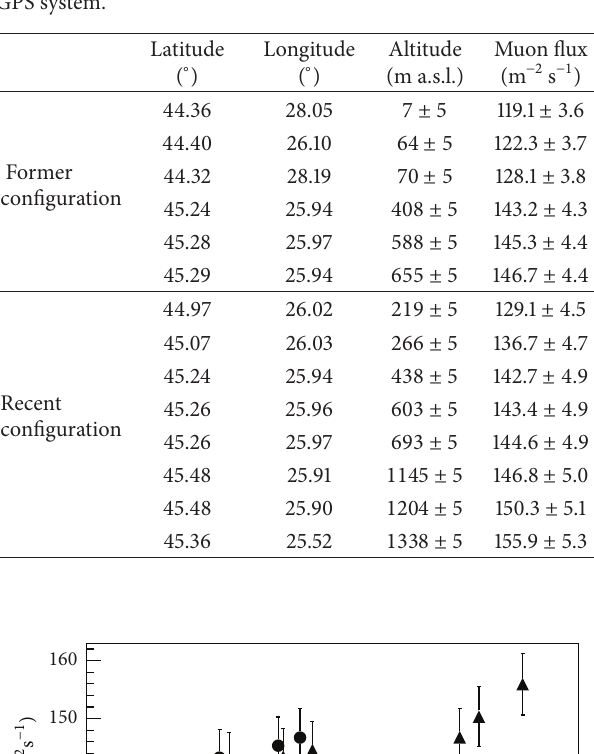
Table 1: Cosmic muon flux measured at different geographic loca- tions with different elevations, using both configurations of the active layers. The altitude and the coordinates were measured with a GPS system.